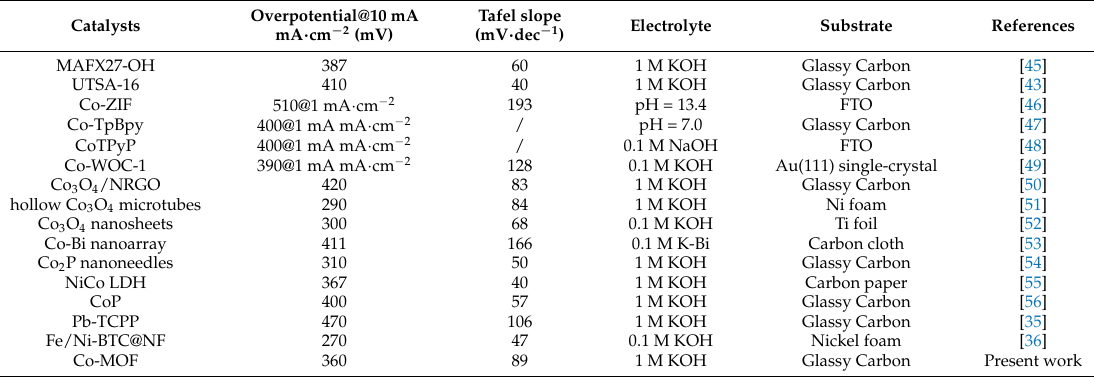
Table 4. Summary of fitted EIS data for 1 and Co 3 O 4